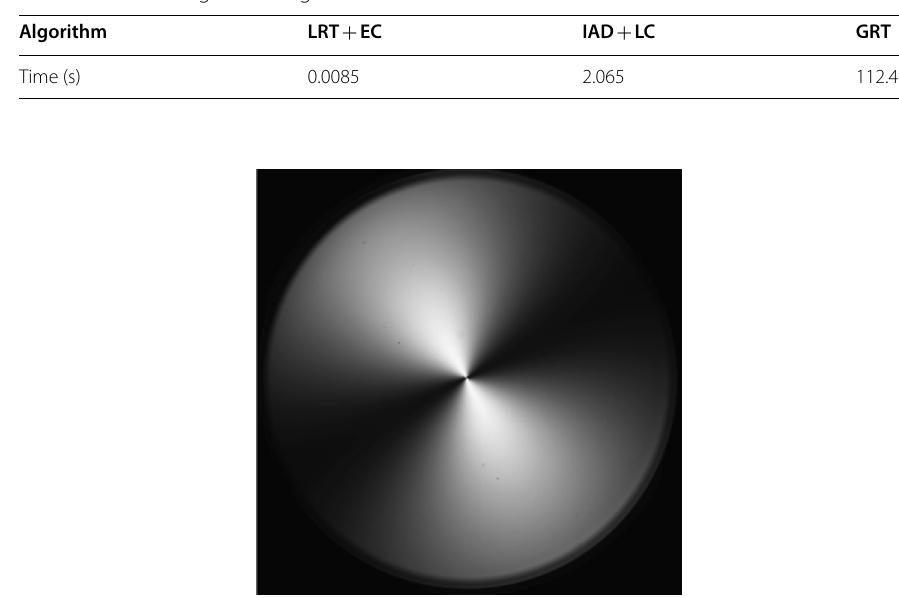
Fig. 8 One of real images used for